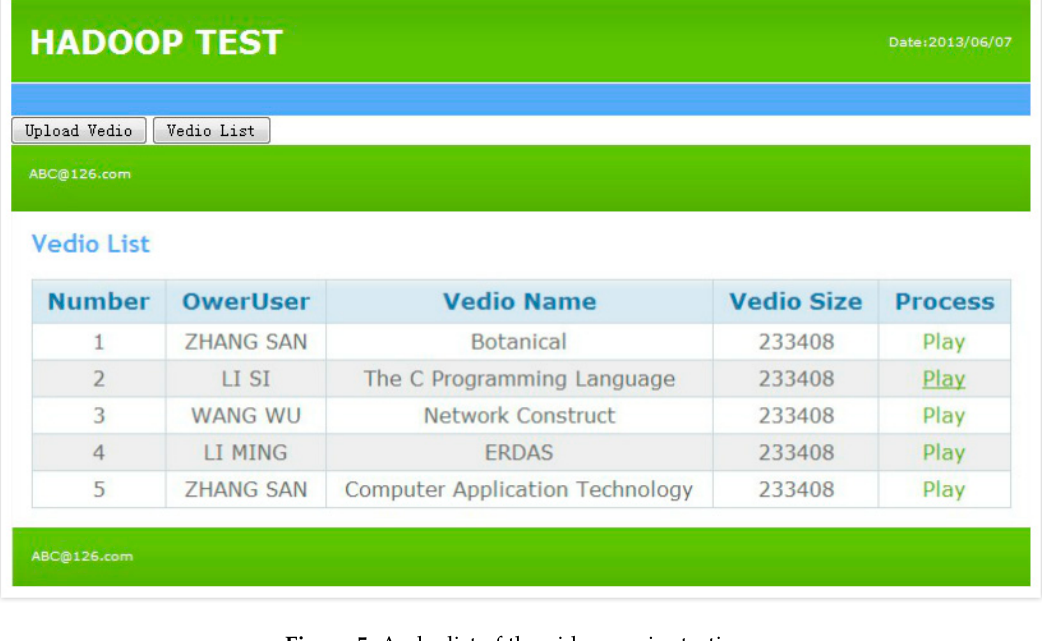
Figure 5. A playlist of the video service testing.